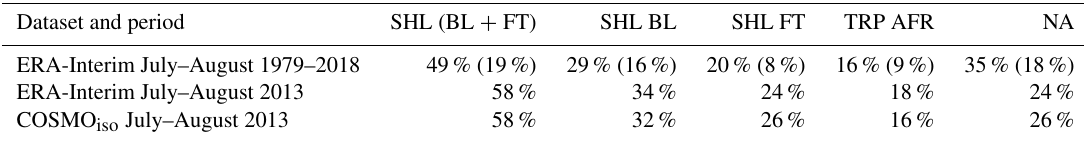
Table 1. Occurrence frequency of the four transport pathways defined in this study based on a classification of backward trajectories started every 6h and from every 20hPa between 500 and 700hPa above Tenerife. Values correspond to averages and interquartile ranges (in brack-